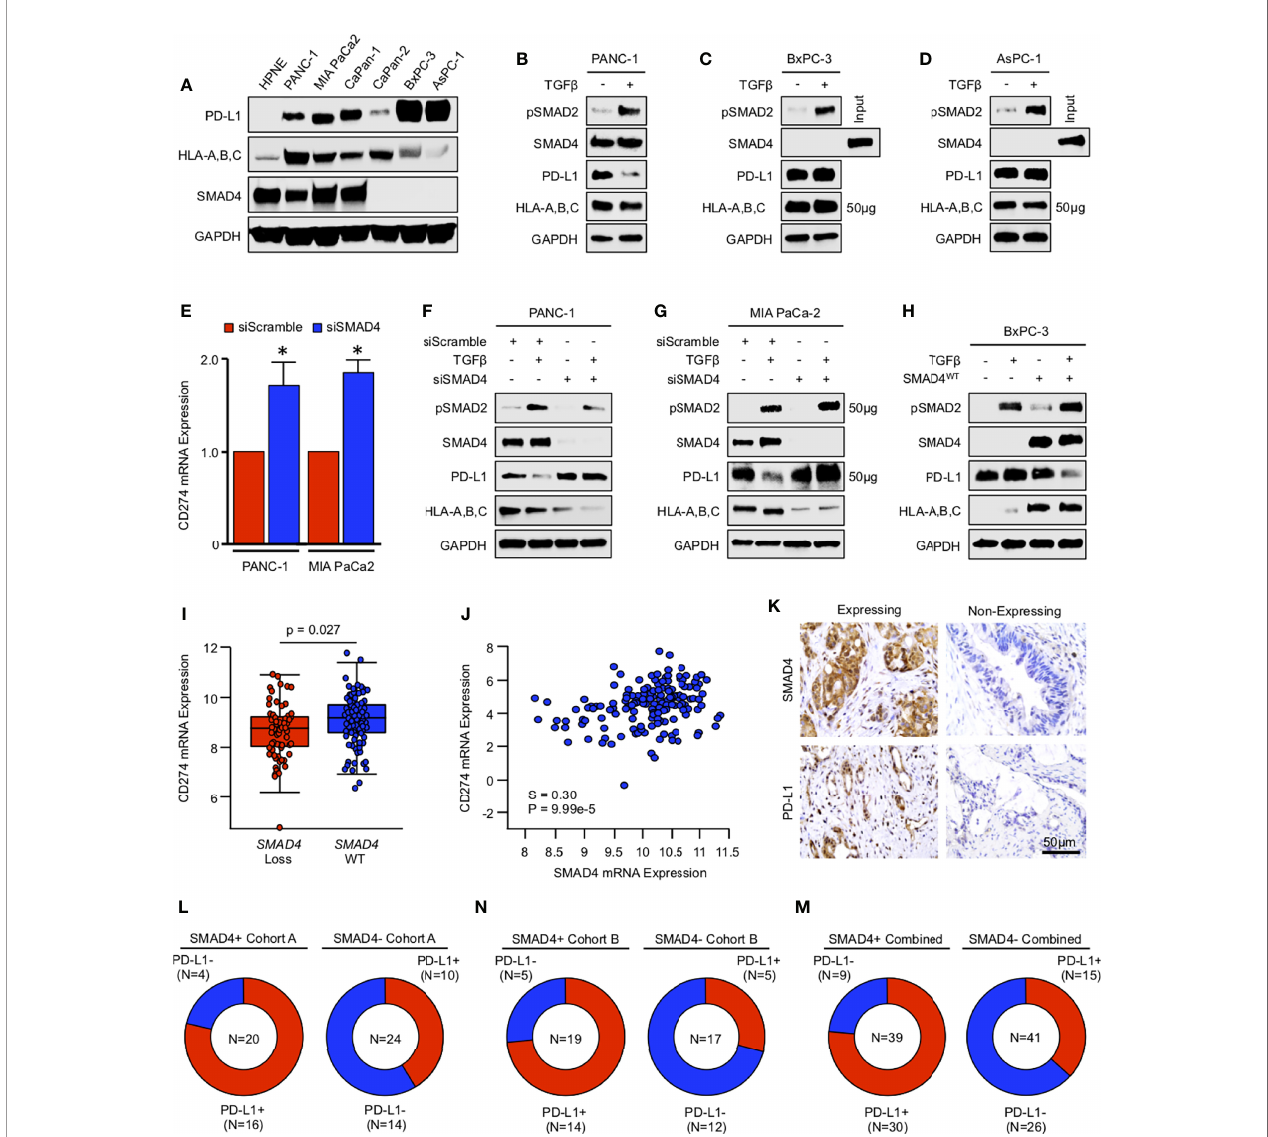
FIGURE 5 | TGF b /SMAD signaling downregulates PD-L1 expression in vitro , yet SMAD4-intact tumors have higher expression of PD-L1 in vivo. (A) Non- malignant HPNE cells and human PDAC cell lines PANC-1, MIA PaCa-2, CaPan-1, CaPan-2, BxPC-3, and AsPC-1 were lysed and analyzed for basal expression of SMAD4, PD-L1, and HLA-A,B,C by western blot. (B-D) PANC-1, BxPC-3, and AsPC-1 cells were incubated with either a saline vehicle or 10ng/mL of recombinant TGF b 1 and evaluated after 24 hours by western blot. (E) PANC-1 and MIA PaCa-2 cells were incubated with either a control siRNA (siControl) or siRNA against SMAD4 (siSMAD4), and after 24 hours, CD274 (PD-L1) mRNA was evaluated by qPCR. (F, G) PANC-1 and MIA PaCa-2 cells were incubated with either siControl or siSMAD4 and, after 24 hours, stimulated with 10ng/mL of recombinant TGF b 1. Cells were lysed after another 24-hour period and evaluated by western blot analysis. (H) BxPC-3 cells were transfected with a wild-type SMAD4 plasmid (SMAD4 WT ). After 24 hours, cells were stimulated with 10ng/mL of recombinant TGF b 1 and evaluated by western blot analysis after another 24 hours. (I) Using the TCGA genomic database of pancreatic cancer patients (N=186), the 149 fully sequenced tumors were separated into two groups: those with no SMAD4 alteration (SMAD4 wild-type or WT), and those with presumptive SMAD4 loss via a known inactivating mutation, mRNA downregulation, and/or copy number deletion. We then compared the mRNA expression of CD274 in each group. (J) SMAD4 mRNA expression was plotted against that of CD274 . All mRNA expression values are plotted in log scale and are displayed with the associated p and Spearmen (S) coef fi cient values. (K) Excisional biopsies from two cohorts of PDAC patients (N=44 and N=36, respectively) were sectioned and stained via immunohistochemistry for SMAD4 or PD-L1. (L-N) Patients were grouped as being either SMAD4-expressing (SMAD4+) or SMAD4-non-expressing (SMAD4-), and the percent of each group also positive for PD-L1 displayed as a pie chart. (*p <